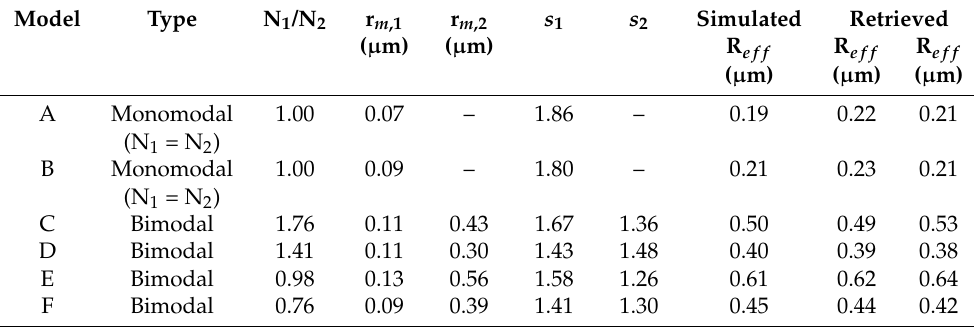
Table 1. Parameters of the six log-normal size distributions of Yue [39,40] used in this study. The first and second columns below the retrieved R ef f correspond to sAOD (at 521 nm) = 0.005 and 0.001, respectively. The number of N i is fixed by 8 in all of the retrieval results because the number of wavelengths is